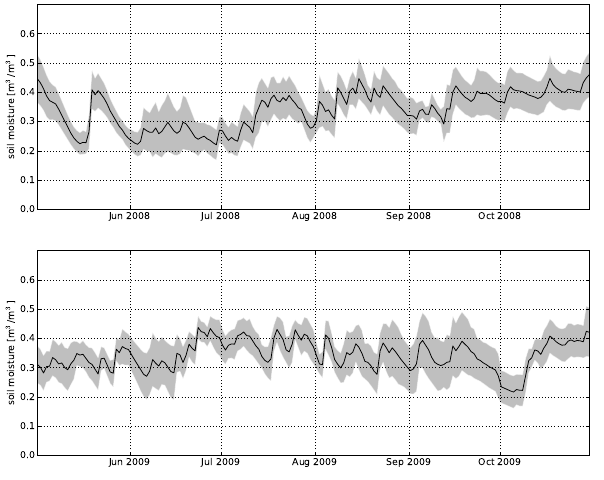
Fig. 2. Temporal evolution of large scale mean soil moisture content ¯ θ as calculated from the average of all ground stations. Greyed area correspond to ± 1 σ θ .